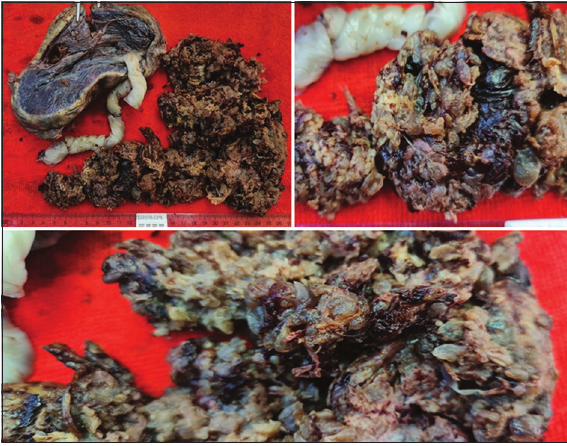
FIGURE 3. Placental disk with eccentric umbilical cord with 02 arteries and 01 vein. Adjacent vesicle-like multicystic tissue, if evidence of fetal